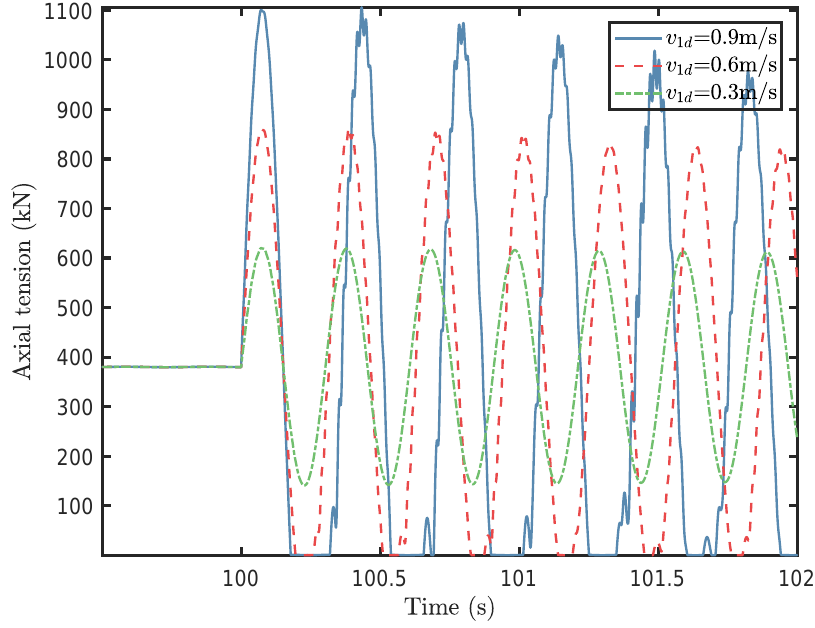
Figure 3. The lift wire tension history of a suspended blade with constant lifting-off